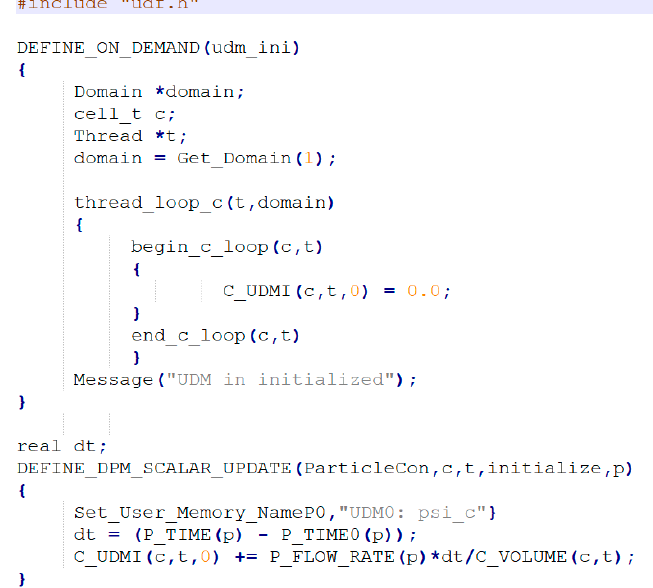
Figure 4. Particle source in cell ( PSI ‐ C) user define function (UDF) code.